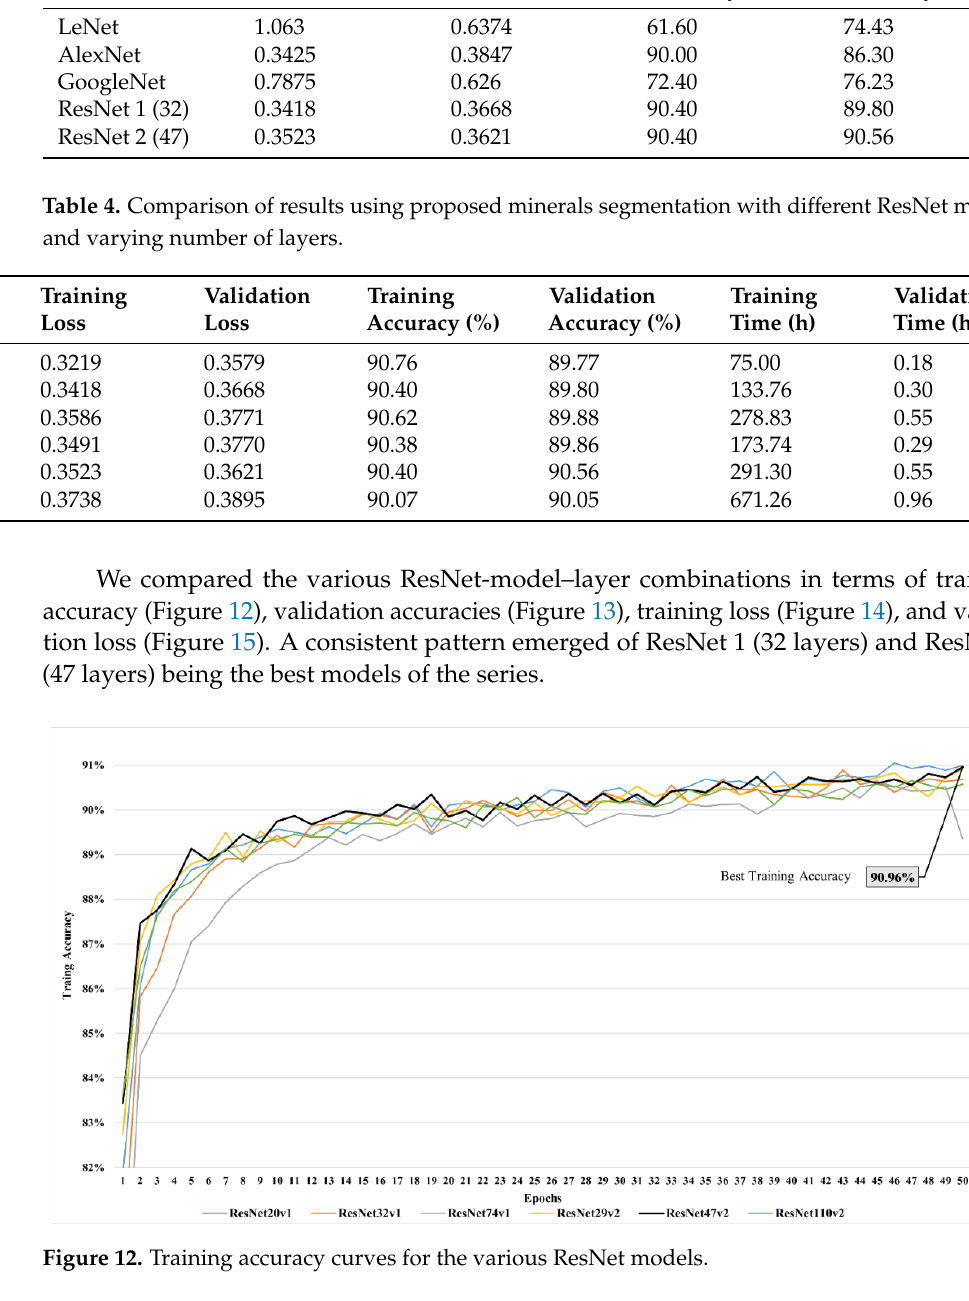
Figure 13. Validation accuracy curves for the various ResNet models.